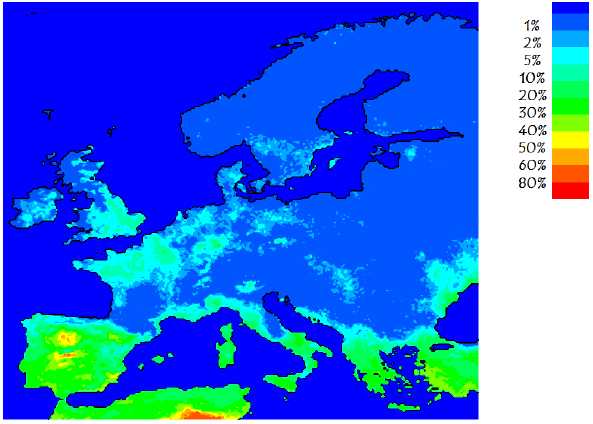
Fig. 6. Percentage of time with low flow “pool” conditions, derived from monthly duration curves for present climate.